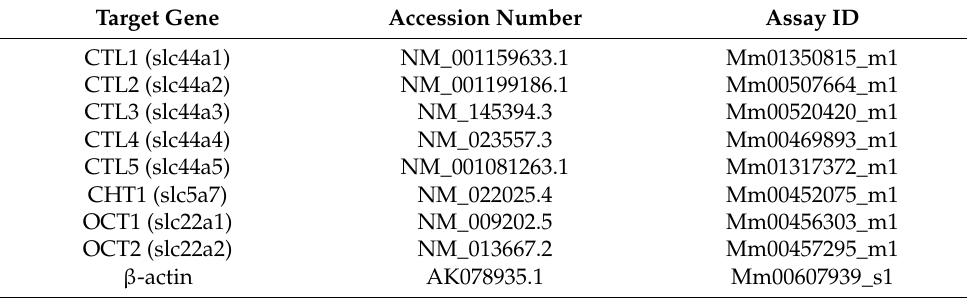
Table 1. TaqMan probes used in the gene expression